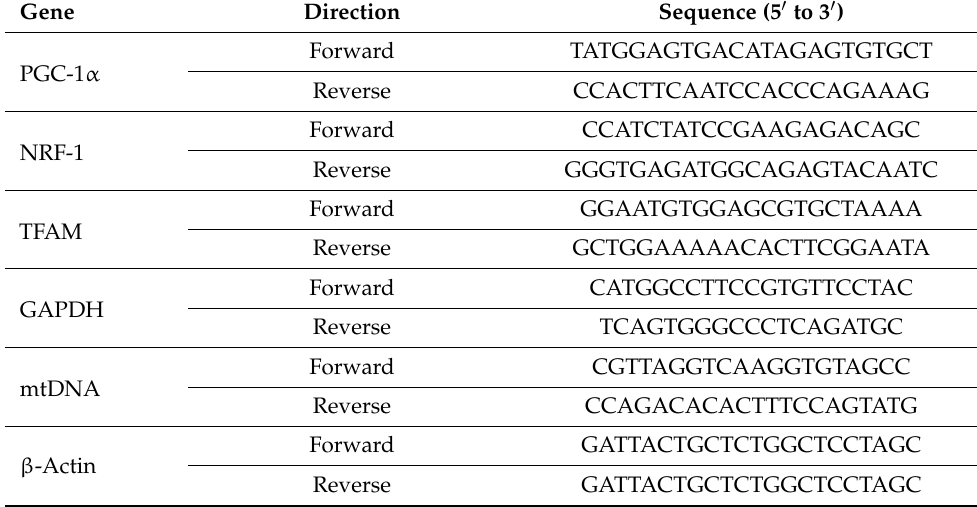
Table 1. List of primer